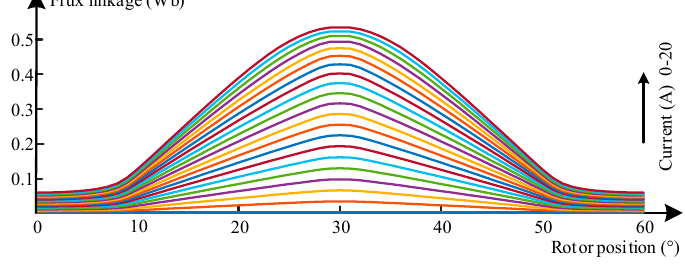
Figure 13. Flux linkage of the SRM. Table 1. Parameters of SRM.